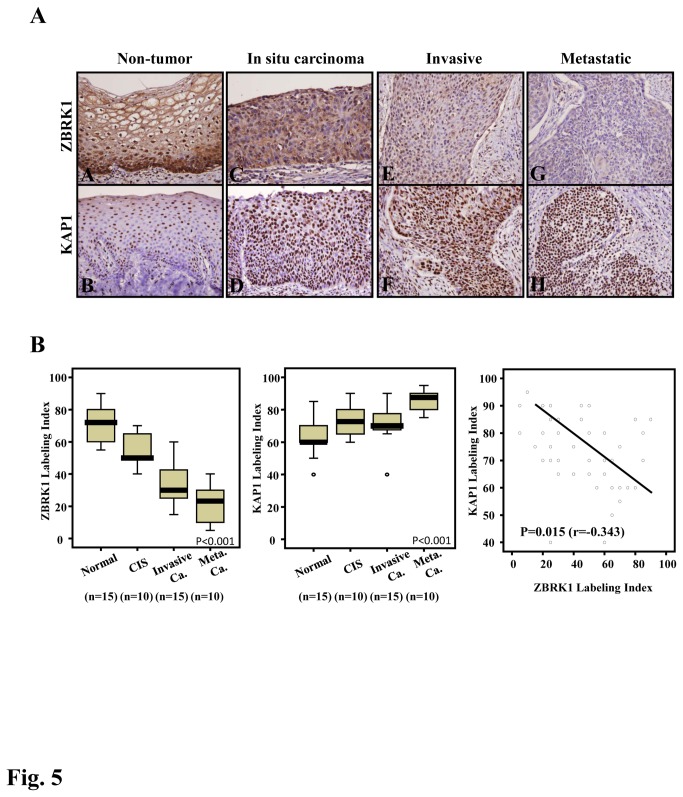
The reduced expression of ZBRK1 is inversely correlated with the increased expression of KAP1 in cervical cancer specimens.
A, All tumor specimens from 50 patients with different stages of cervical cancer were obtained from surgically resected tissues. ZBRK1 and KAP1 expression was detected in non-tumor epithelium (A, B), in situ carcinoma (C, D) and invasive (E, F) and nodal metastatic carcinoma (G, H) using immunohistochemistry. B, A representative image of ZBRK1 demonstrates a significant stepwise decrease, whereas KAP1 had significantly elevated expression. The expression levels of ZBRK1 or KAP1 in normal, CIS, invasive cancer and metastatic cancer were calculated using analysis of variance (ANOVA); p< 0.001 was considered to be significant. ZBRK1 and KAP1 expression levels between the tumor stages were compared using the Chi-squared test, for which two-sided tests of significance were used. A value of p< 0.05 was considered to be significant.